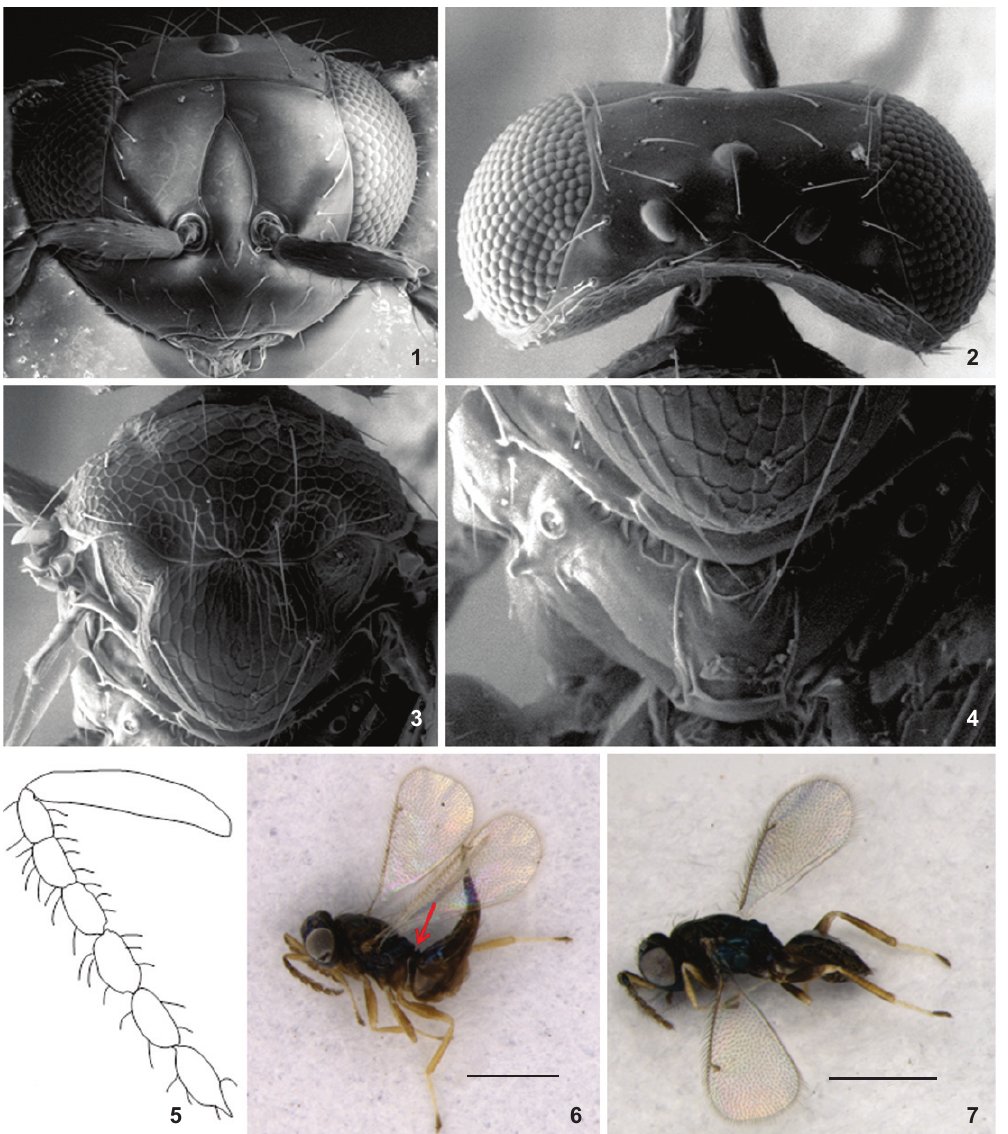
Figs 1-7. Emersonella appendigaster sp. nov. , female: (1) frontal view of head; (2) dorsal view of head; (3) dorsal view of mesonotum; (4) dorsal view of scutellum and propodeum; (5) antenna; (6) lateral view of female showing the insertion of petiole at the top of the gaster; (7) lateral view of male. Scale bars: 5-6 = 500